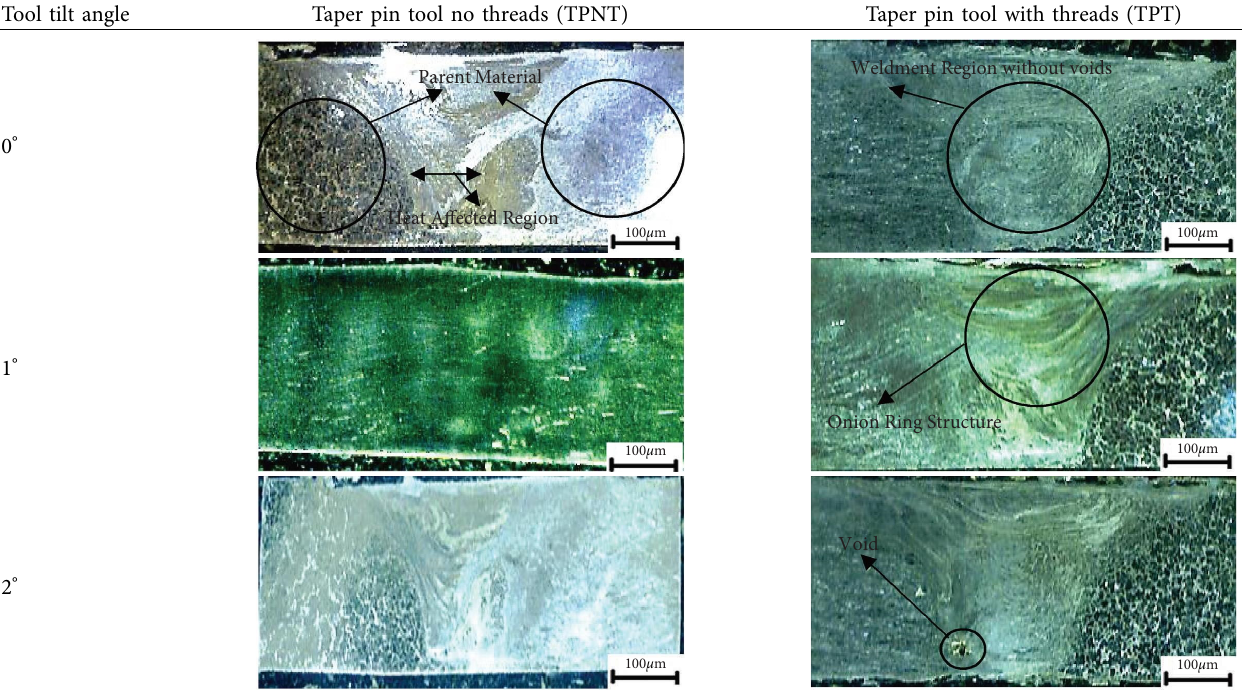
Table 4: Macrostructural cross-sectional